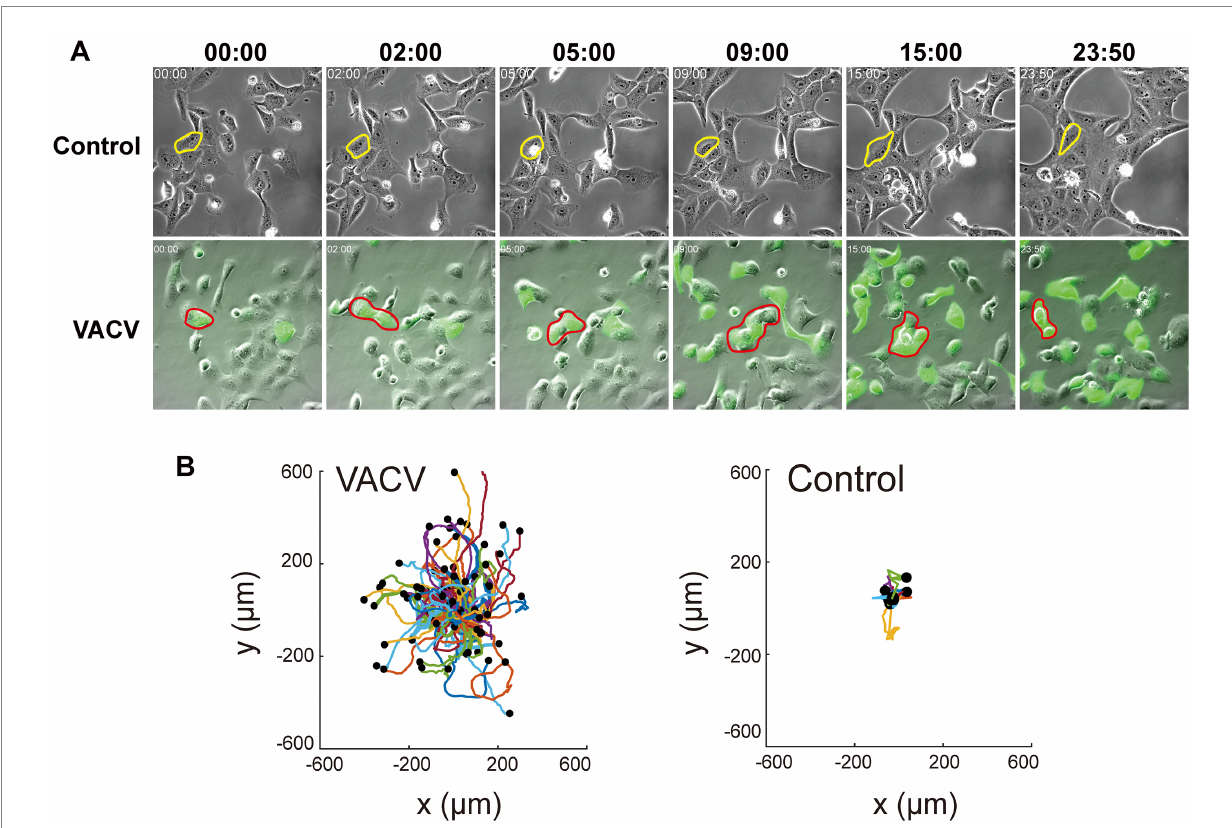
FIGURE 1 VACV infection induces faster Vero cell migration. (A) The images at different time points of the non-infected and VACV-infected Vero cells within 24 h.p.i. One of the typical cells in each group has been circled to clarify the movement. (B) The cell trajectory analysis of non-infected and VACV- infected Vero cells at 24